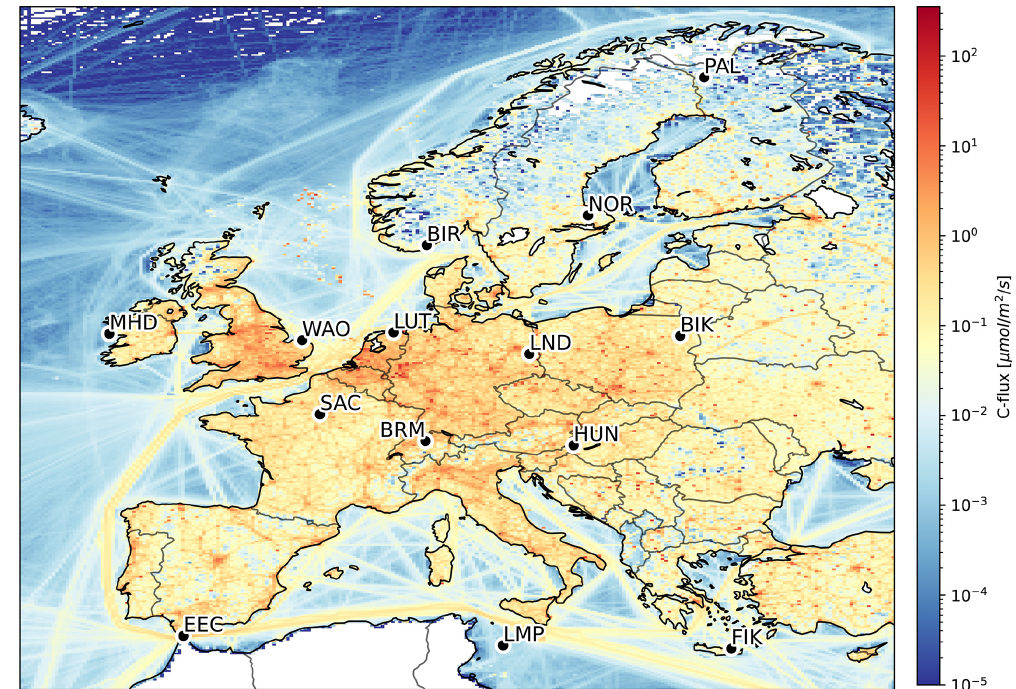
Figure 2. Estimated anthropogenic combustion emissions for 8 July 2018, 12:00UTC as an example of the anthropogenic emission part of our product. Black dots indicate the location of used ICOS CO 2 measurement sites. Table 4. Ratio of total CO 2 emissions from CAMS for 2017. The included column shows whether a sector is included in the final data product and included in the emissions presented in the remainder of this paper. Downscaled sectors are subject to near-real-time information as described in the text. GNFR Long name Ratio of total emissions Included Downscaled